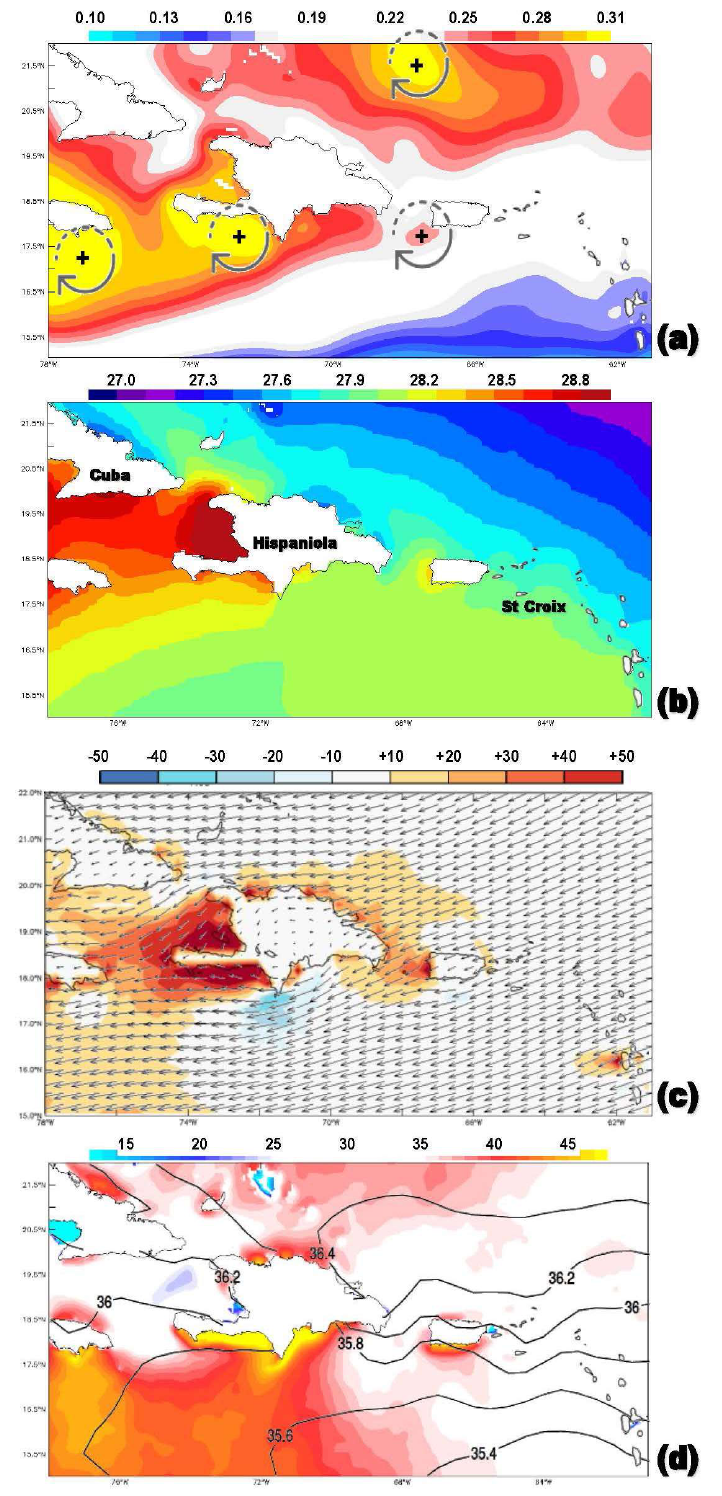
Figure 1. Mean annual maps of: ( a ) SSH (m), ( b ) satellite SST (°C), ( c ) ERA5 wind vector and net heat flux (shaded, W/m 2 ) highlighting wind shadows, and ( d ) HYCOM mixed layer depth (shaded, m) and 1–30 m salinity (contours, ppt). Standing anticyclonic eddies labelled + in ( a ); all averaged 2000–2019. To quantify low-frequency fluctuations of inflow to the northern Caribbean, monthly SODA3 zonal (U) and meridional (V) 5–200 m depth-averaged currents were subjected to